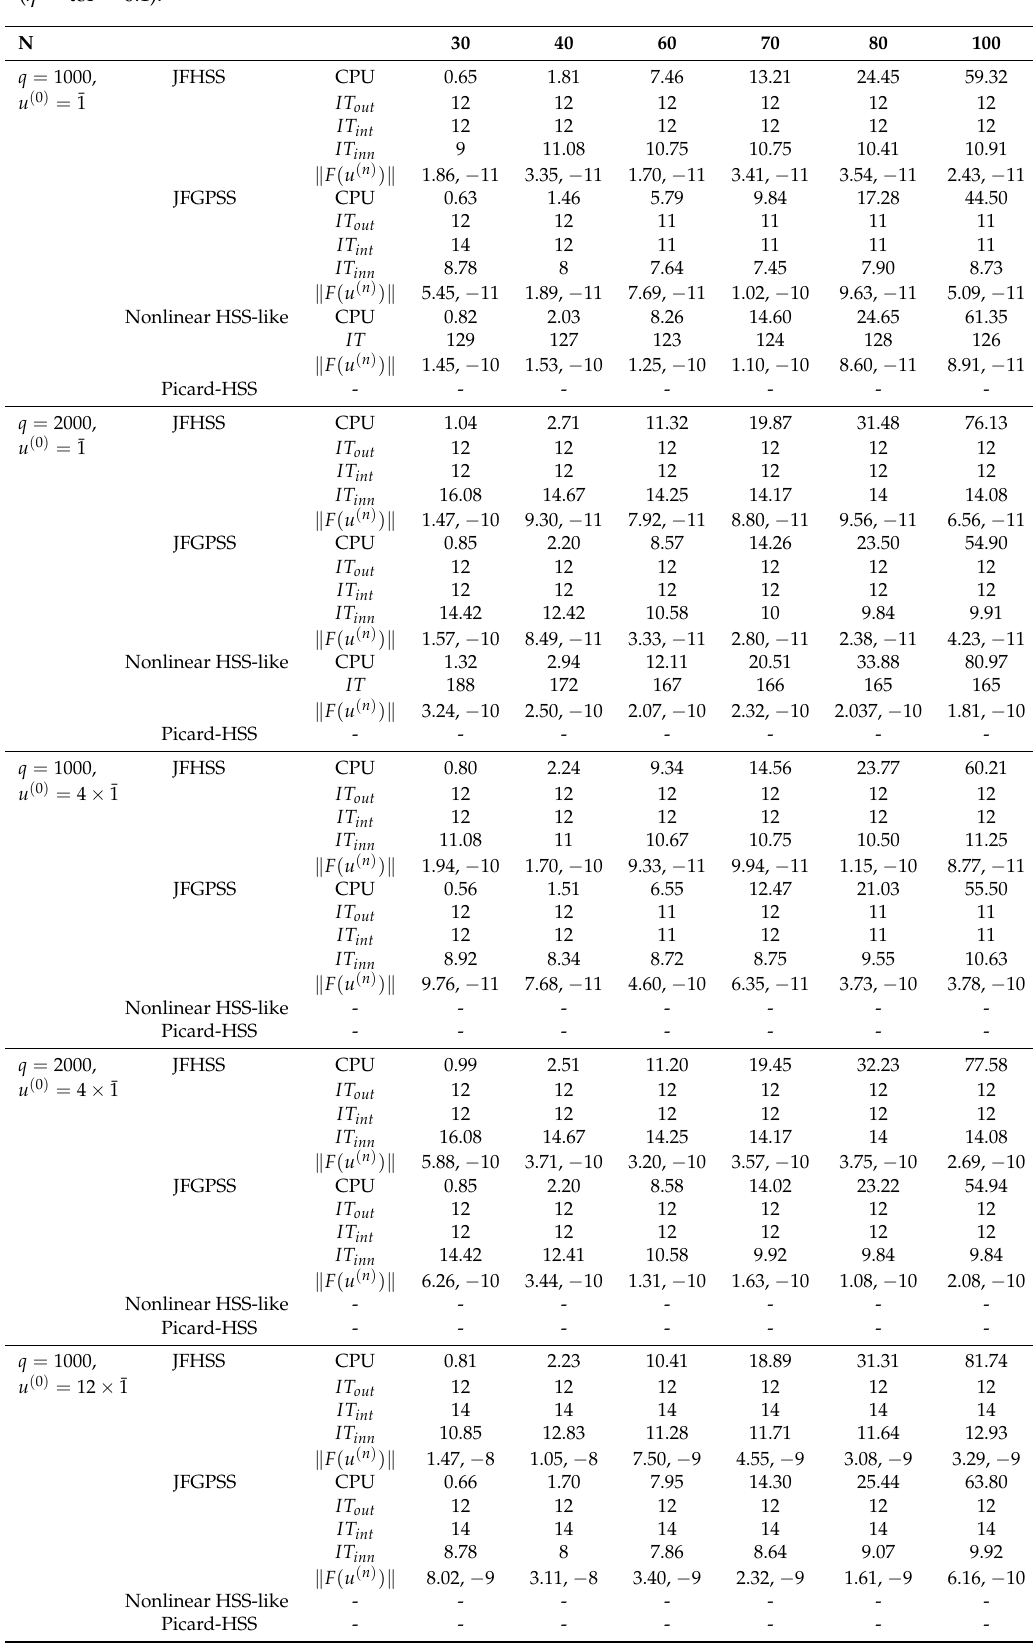
Table 1. Results for JFHSS, JFGPSS, nonlinear HSS-like and Picard-HSS methods of Example 1, Case 1 ( η = tol =